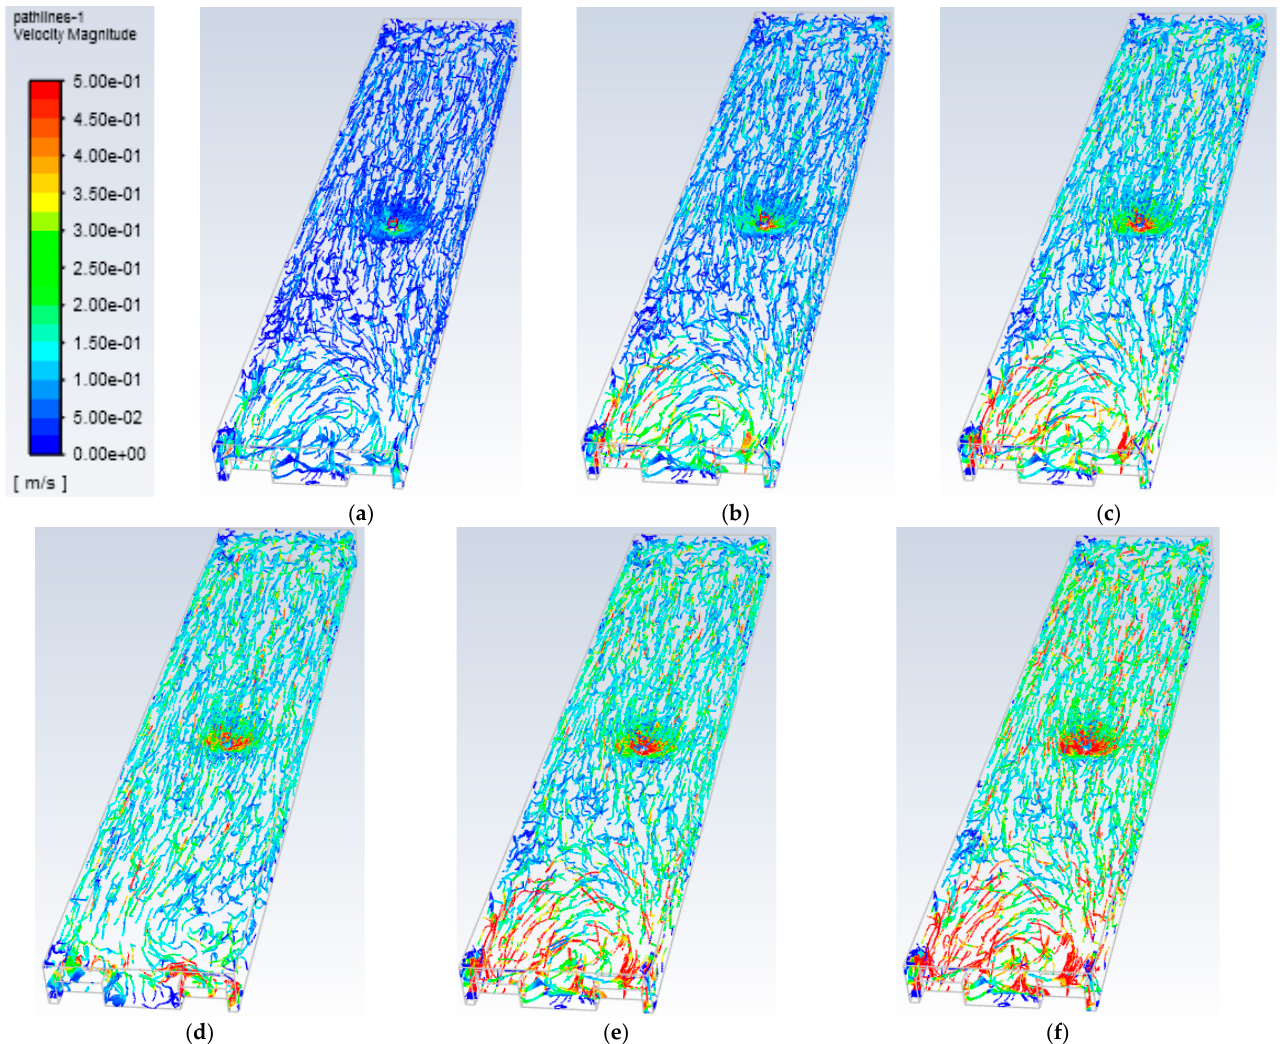
Figure 6. Distributions of air flow at different inflow velocities: ( a ) 0.5 m/s, ( b ) 1 m/s, ( c ) 2 m/s, ( d ) 3 m/s, ( e ) 4 m/s, ( f ) 5 m/s.